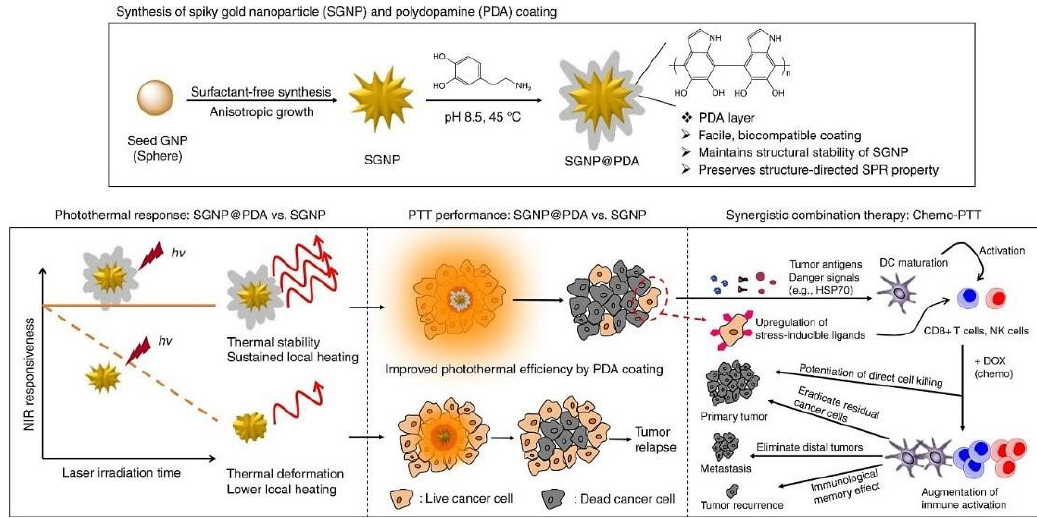
Figure 3. Schematic illustration of spiky Au NPs coated with Polydopamine (PDA) (SGNP@PDA) and photothermal properties. The combination of chemo-photothermal therapy triggered potent anti- cancer immunity in vivo and anti-tumour efficacy against local primary tumours/untreated and distal tumours. In addition, long-term immunity against tumour recurrence was found. Reproduced with permission from [110], Copyright Nature, 2018.